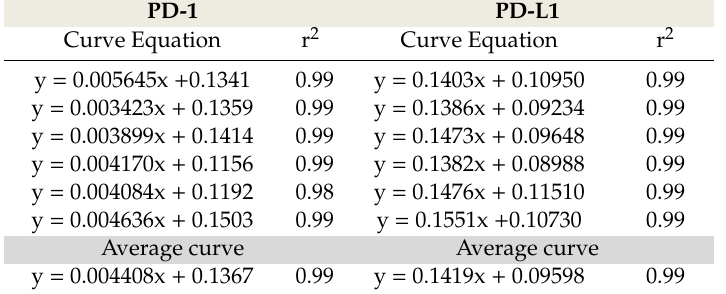
Figure 5. Average and standard deviation of 6 independent standard curves of a-PD-1 in blue and a-PD-L1 in red. Table 1. Regression curves and r 2 calculated for each calibration curve and for the average curve. PD-1